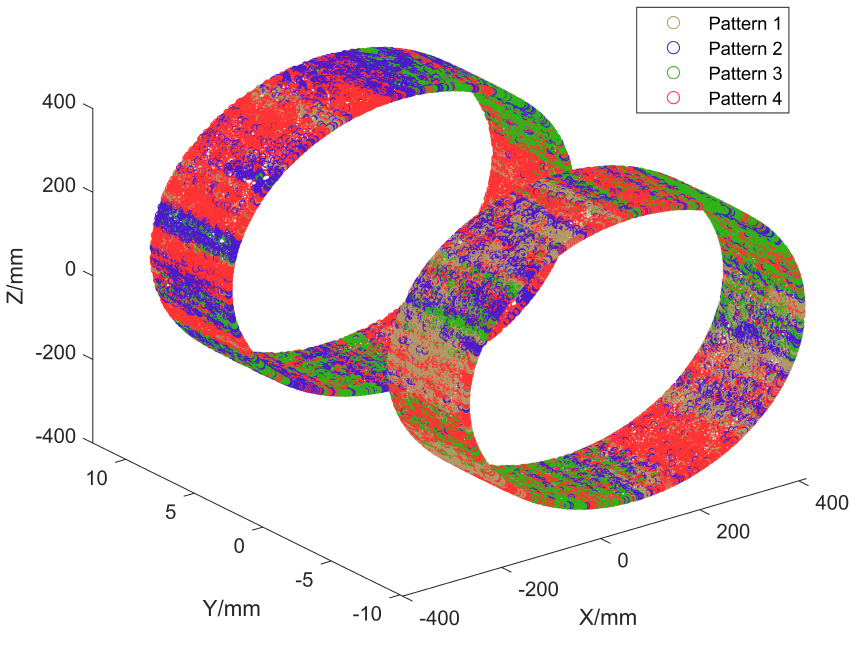
Figure 7. Tightening pattern comparison. Table 2. Superiority percentage of tightening